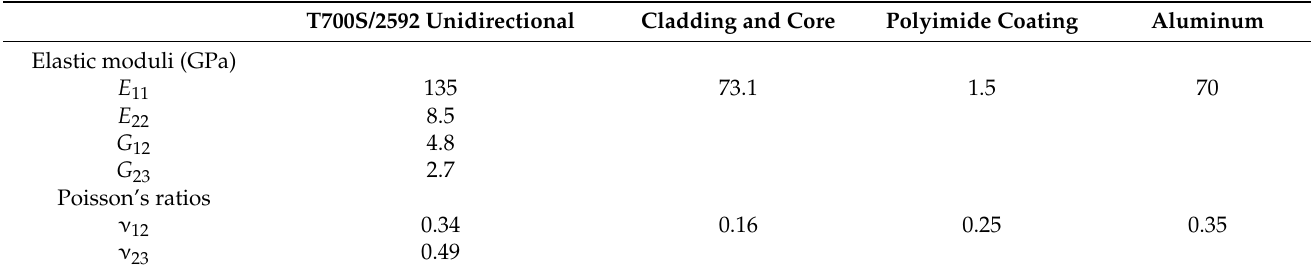
Figure 5. Finite element model for sensor response evaluation. Table 1. Material properties used for finite element analysis.